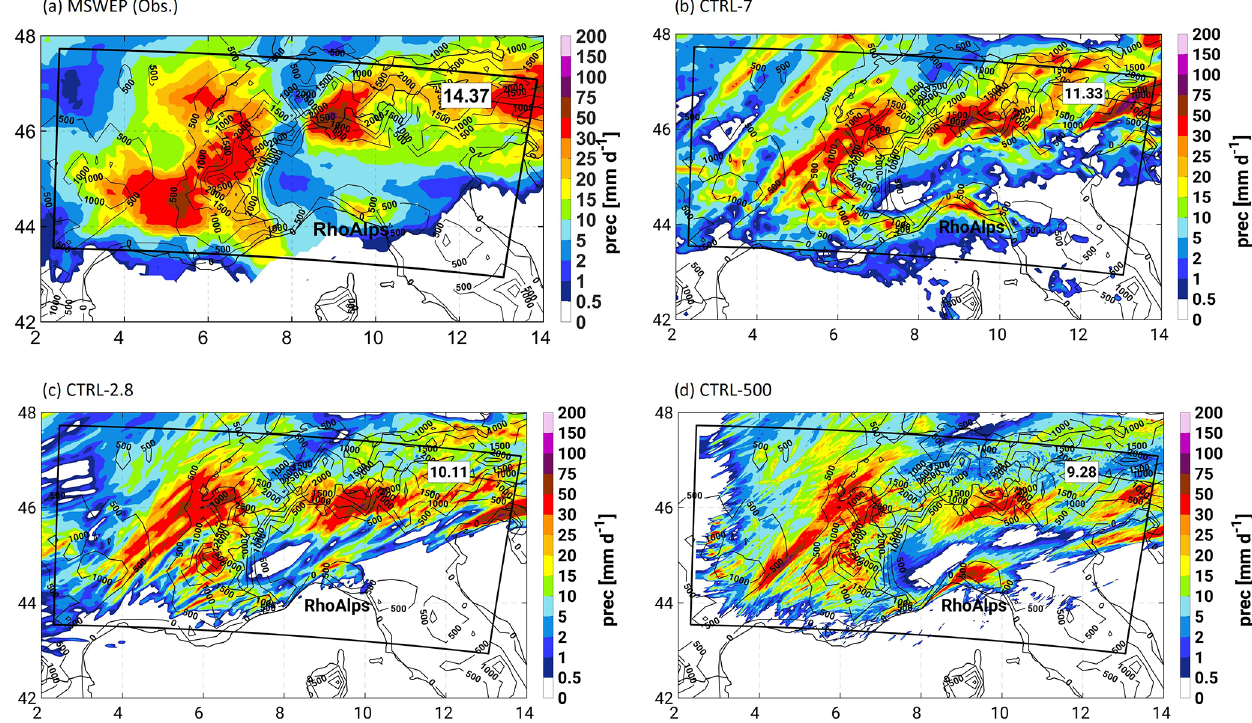
Figure 3. Spatial distribution of daily precipitation during 24 September 2012 00:00UTC to 25 September 00:00, estimated by the MSWEP v2.1, 3-hourly, 0.1 ◦ (a) and simulated by CTRL-7 (b) , CTRL-2.8 (c) , and CTRL-500 (d) . The labels within the RhoAlps box show the values of the spatial averages used in Fig. 5a for validation of the precipitation